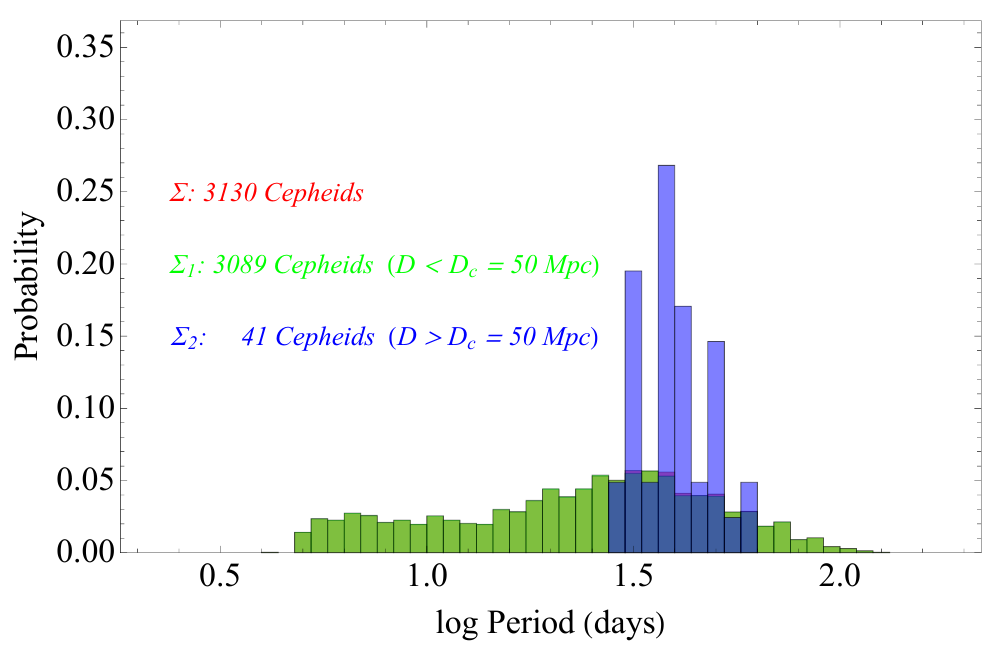
Figure 6. Probability distributions of the Cepheid period for the whole Cepheid sample and for the high ( D > D c ) and low distance ( D < D c ) subsamples for D c = 50 Mpc. Due to the small number of Cepheids in the D > 50 Mpc bin (41), the probability distribution of the full sample (3130 Cepheids) is almost identical to the probability distribution of the D < 50 Mpc bin, and thus the light green bars overlap with the red